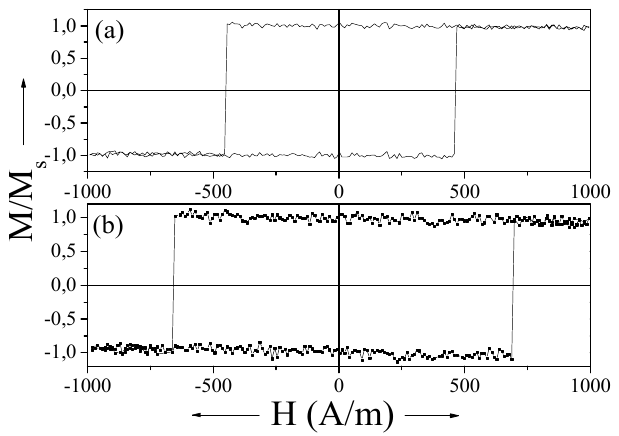
Figure 11. Hysteresis loops of as-prepared Fe 38.5 Co 38.5 B 18 Mo 4 Cu 1 microwires: with ρ = 0.41 ( a ) and ρ = 0.6 ( b ) measured at f = 50 Hz. Reproduced from reference [70], Figure 1.